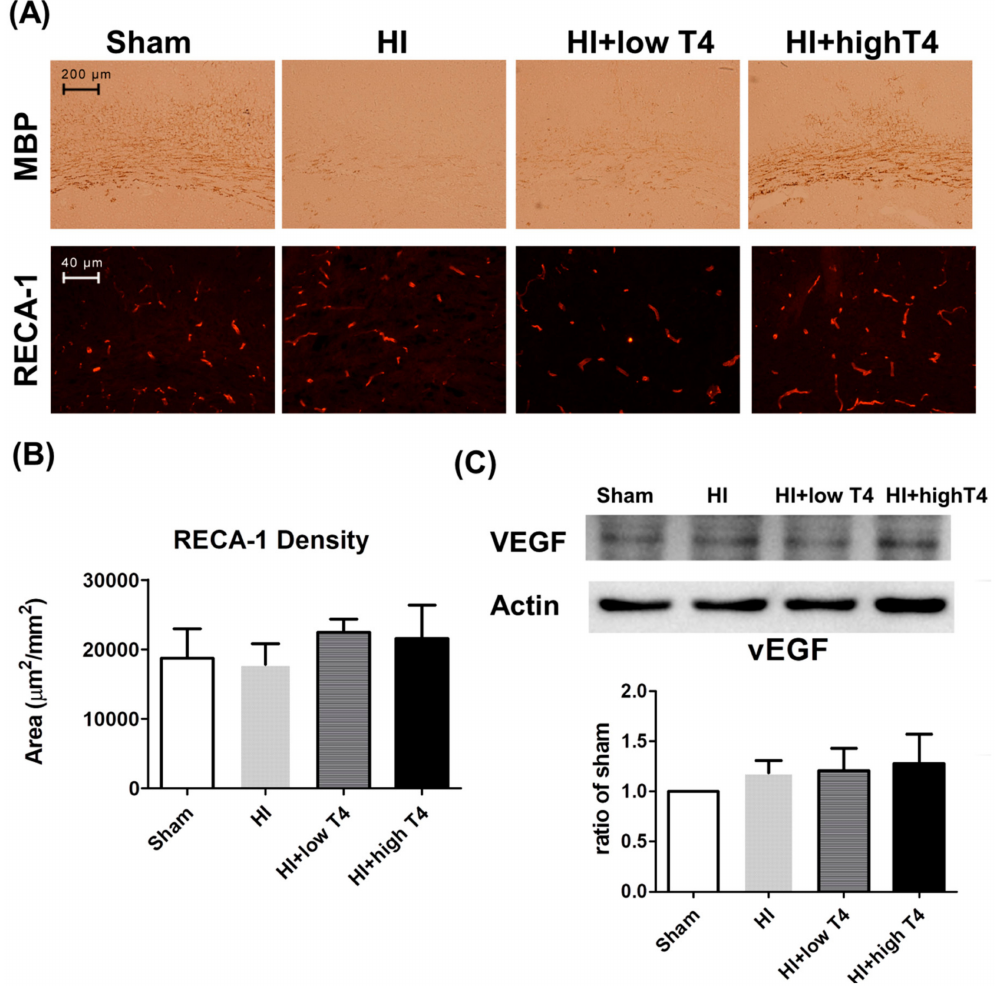
Figure 6. T4 treatment restored myelination but did not alter neovascular remodeling following WM injury. ( A ) A high dose of T4 treatment enhanced myelination, as evident from MBP staining, whereas antiendothelium cell antibody (RECA-1) staining, a marker of neovascular angiogenesis, was similar across groups. Scale bar, 200 µ m. ( B ) HI or HI+T4 treatment had no effect on RECA-1 levels. Scale bar, 40 µ m. ( C ) HI or HI+T4 treatment had no effect on vascular endothelium growth factor (VEGF)